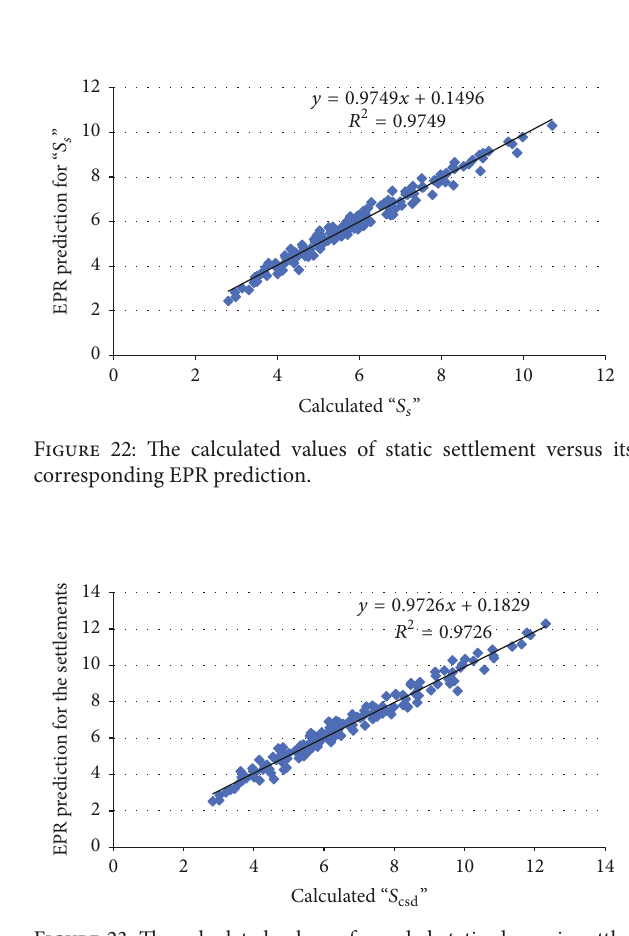
Figure 23: The calculated values of coupled static-dynamic settle- ments versus its corresponding EPR